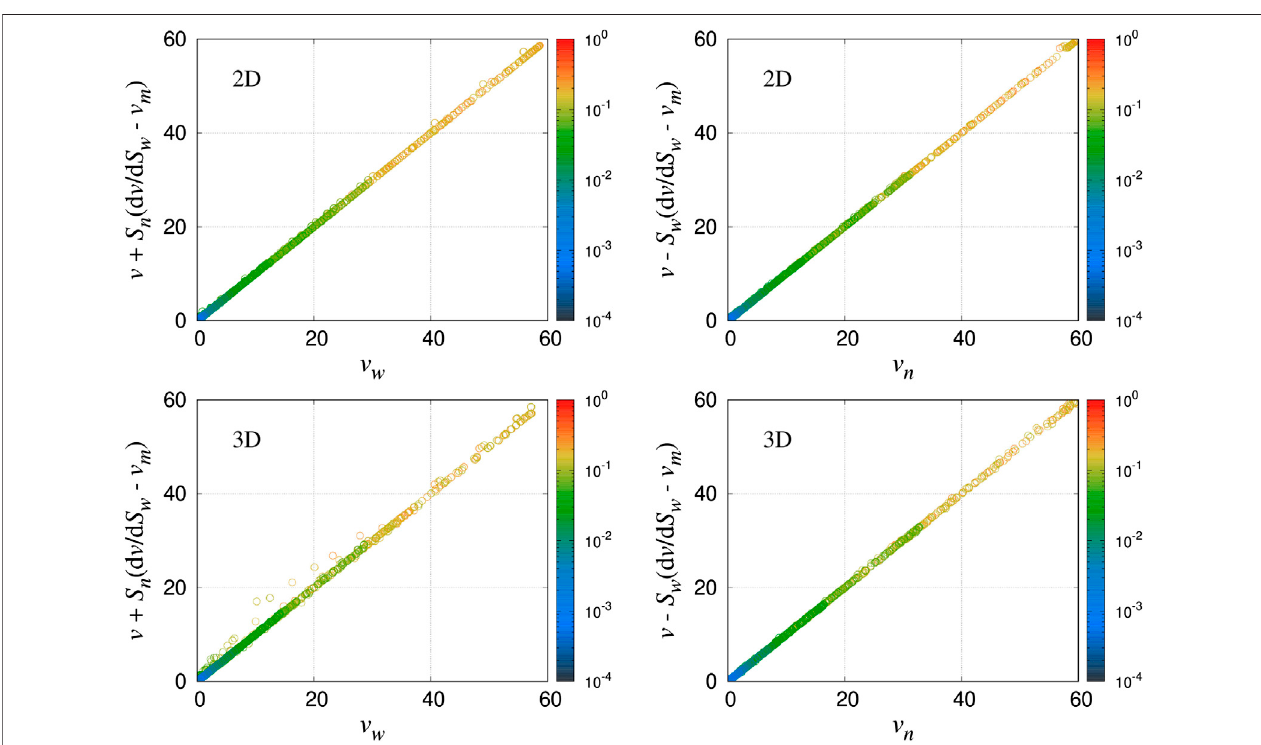
FIGURE14| Plotofthewettingandnon-wettingseepagevelocities(mm/sec)calculatedusing Eq.27 againstthemeasured valuesof v w and v n forthesquare(top row) and Berea (bottom row) network. The derivatives are calculated using the central difference techniques. The color scale shows the capillary numbers.